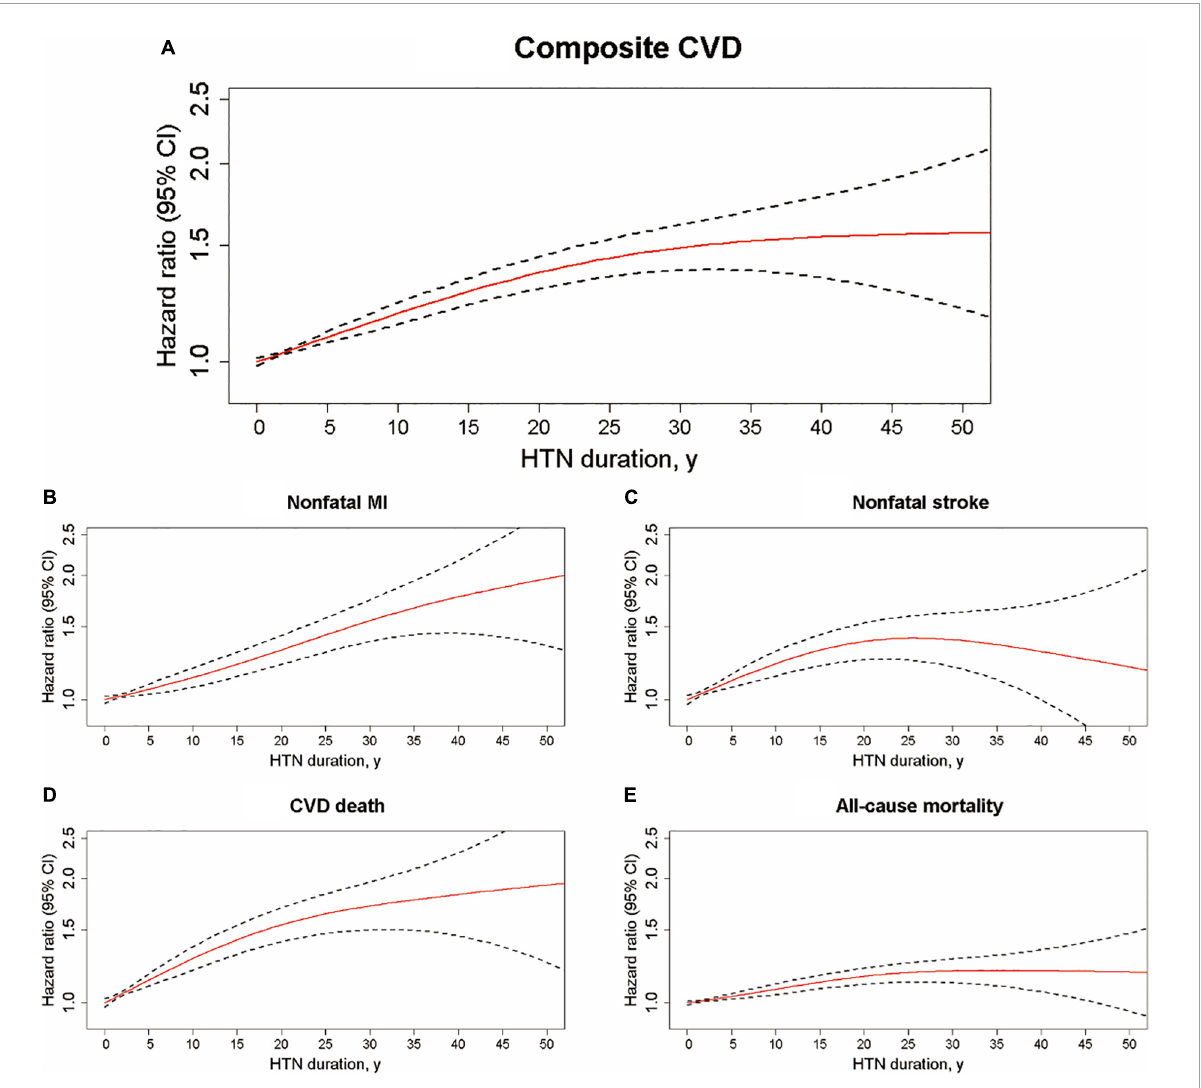
FIGURE1 Hypertension duration on a continuous scale and risks of cardiovascular disease and all-cause mortality among participants with hypertension. Hazard ratio (solid red line) and 95% confidence interval (dashed black lines) from Cox regression using penalized splines. Multifactorial adjustments were made for age, sex, ethnicity, Townsend score, body mass index, smoking, healthy diet score, diabetes, longstanding illness, hypertensive drug use, cholesterol-lowering medication use, systolic blood pressure and diastolic blood pressure. HTN, hypertension; CVD, cardiovascular disease; MI, myocardial infarction. (A) HTN duration and composite CVD, (B) HTN duration and nonfatal MI, (C) HTN duration and nonfatal stroke, (D) HTN duration and CVD death, and (E) HTN duration and all-cause